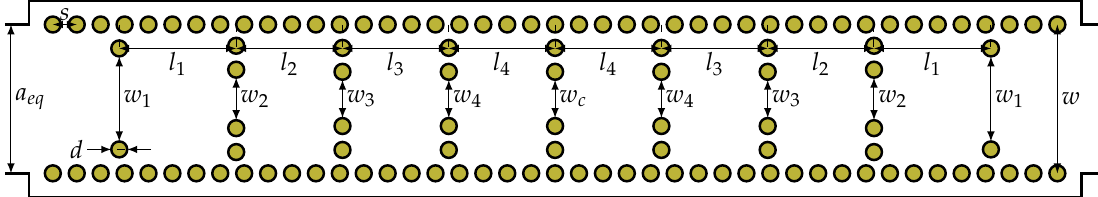
Figure 12. Layout of the eight pole SIW filter: w = 10.8430 mm, s = 1.5 mm, d = 1 mm, l 1 = 8.2821 mm, l 2 = 9.3734 mm, l 3 = 9.6392 mm, l 4 = 9.6943 mm, w 1 = 6.1832 mm, w 2 = 4.6753 mm, w 3 = 4.2710 mm, w 4 = 4.1763 mm, and w c = 4.1534 mm.